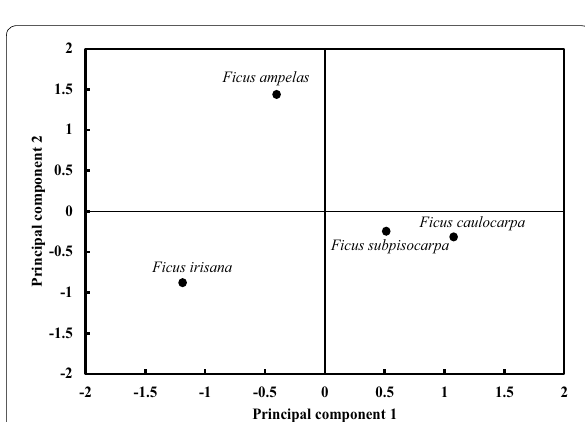
Fig. 4 Principal component analysis of nutrient contents of four fig species assessed in HTBC (see Table 4 for each nutrient component). PC1, with increasing lipid and fiber but decreasing carbohydrate contents, and PC2, with increasing calcium and protein contents, accounted for 80.65% of the total